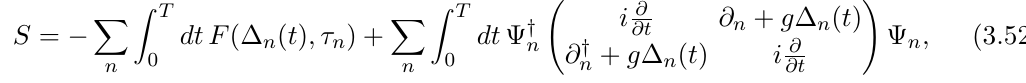
, ( N − n 0 ) . The solid lines are the corresponding 0